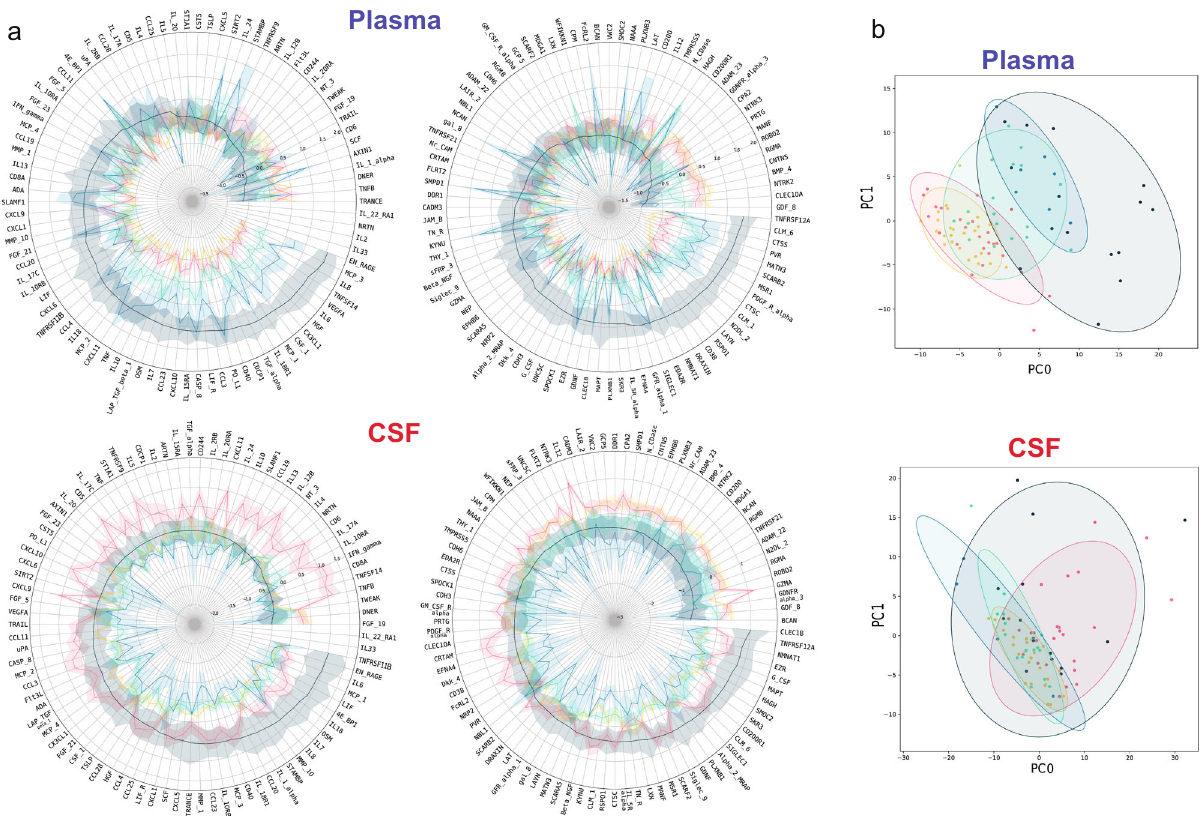
Fig. 4 | Neuro-COVID patients display a vigorous peripheral immune response and speci fi c CSF alterations including analytes with high predictive value for class III development and strong CSF-plasma correlation. a Rose plots repre- senting Z-scores of marginalized normalized protein expression (NPX) of 192solubleproteinsinCSFandplasma.Forbettervisualization,analyteshavebeen grouped into ‘ in fl ammatory ’ (left panels) and ‘ neurological ’ (right panels) proteins.